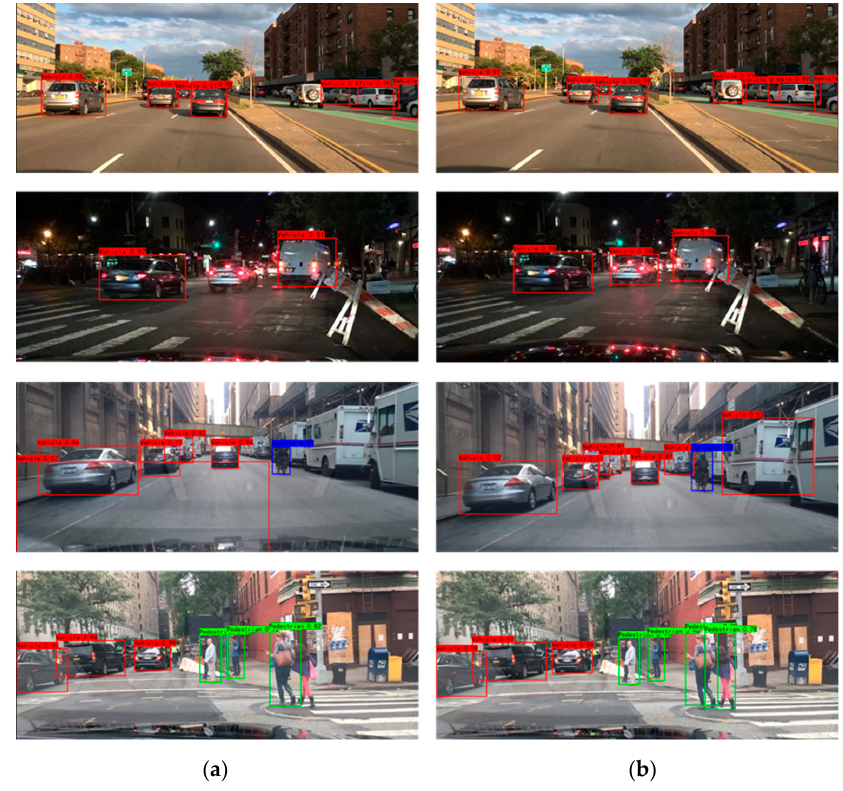
Figure 17. Object detection results of KITTI dataset: ( a ) YOLOv4; ( b ) VV-YOLO.